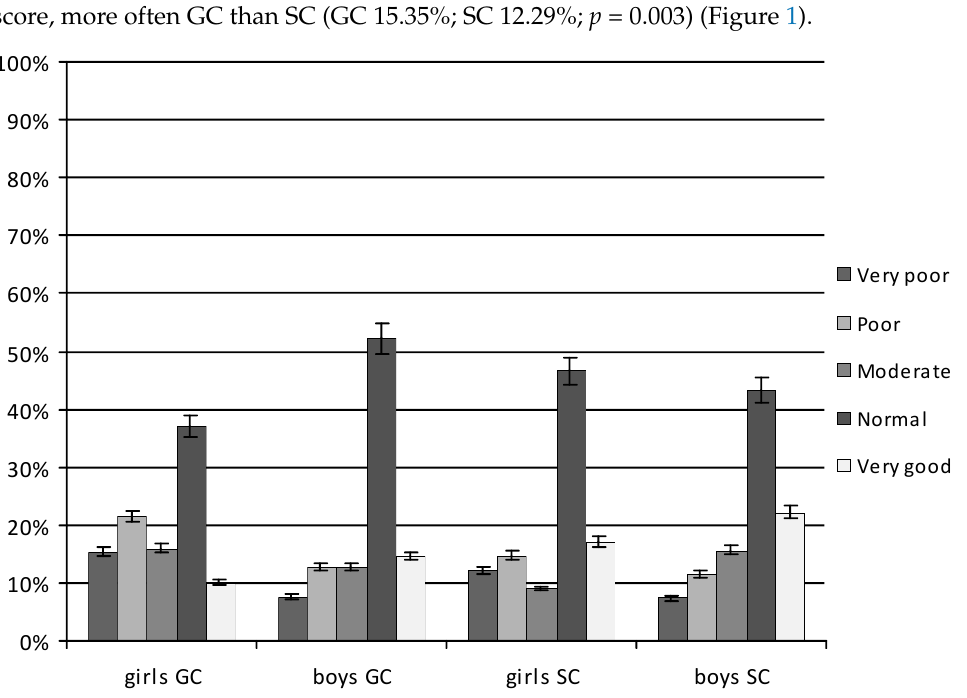
Figure 1. Results of the 30 s sit-up test, an average over the study period. GC—general education classes; SC—sport